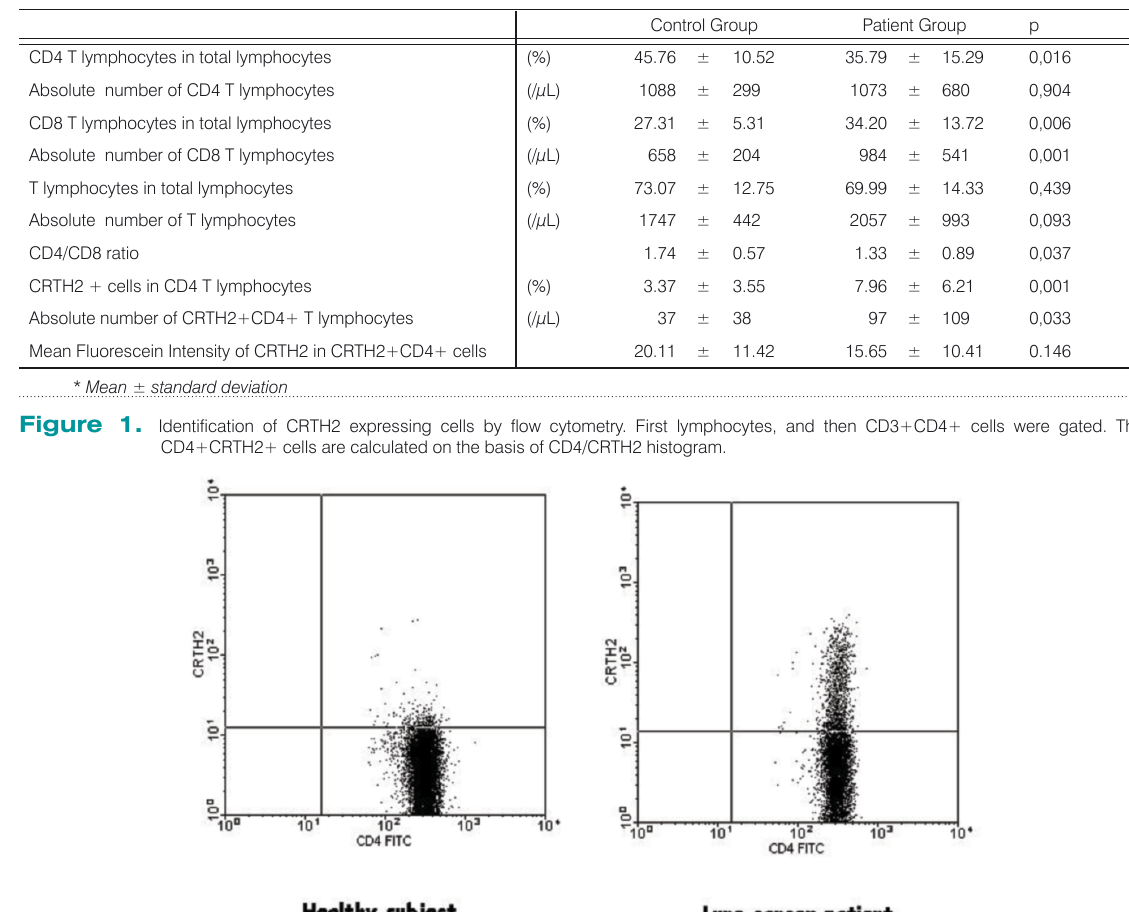
Table 3. Flow Cytometric